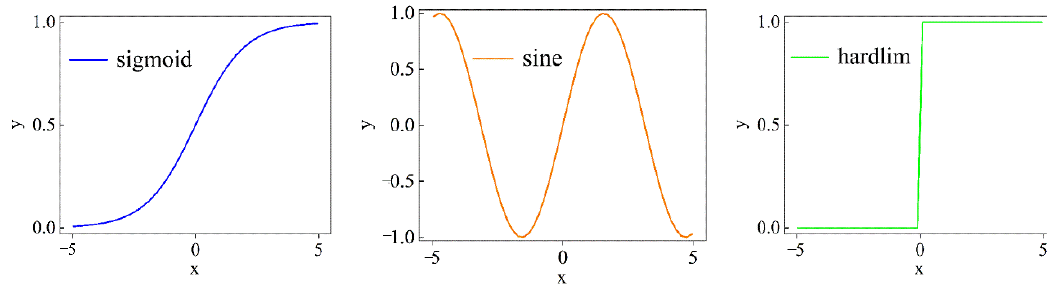
Figure 3. Various types of activation functions of ELM.